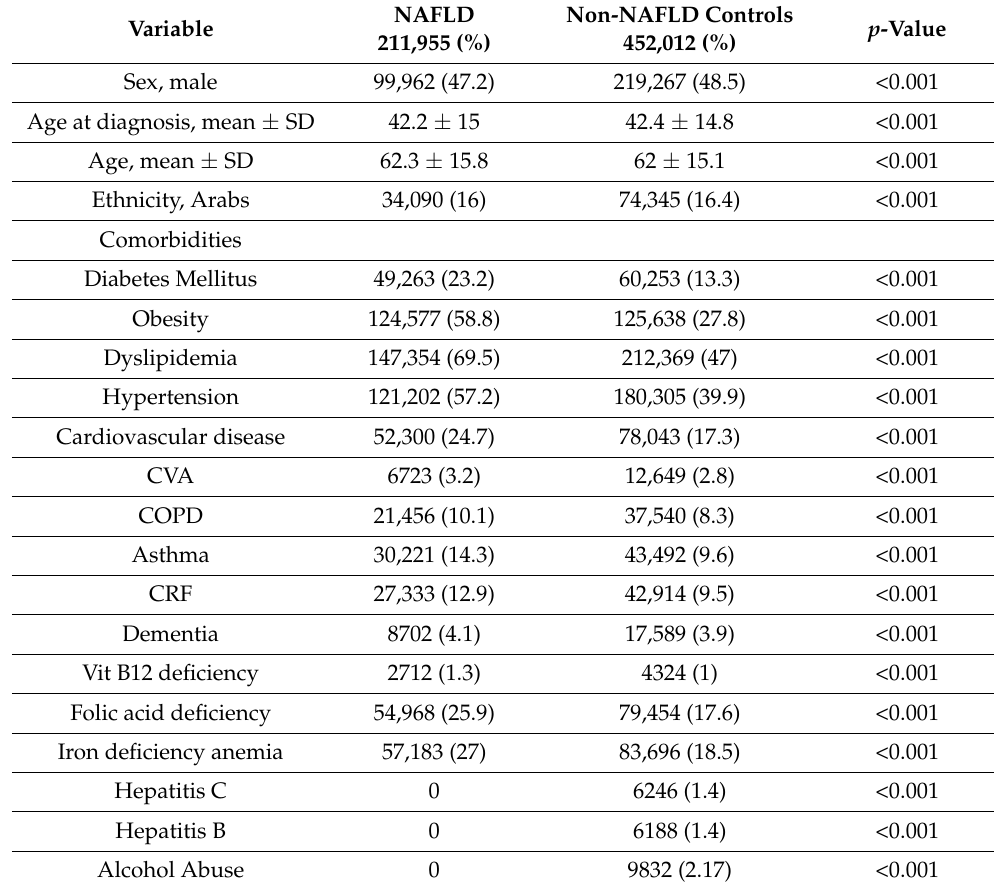
Table 1. Baseline characteristics and comorbidities of NAFLD and non-NAFLD groups.